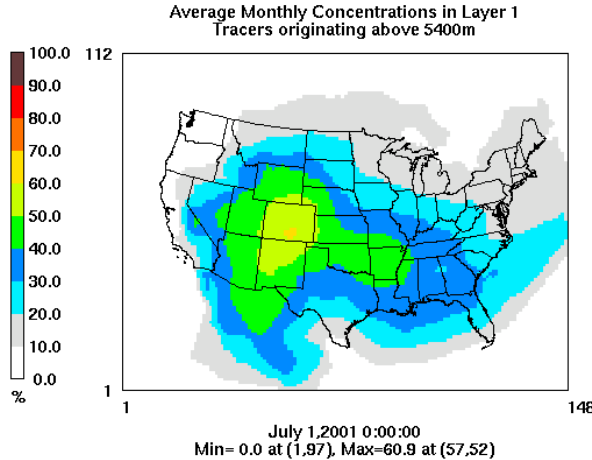
Fig. 12. Percent contribution of tracers originating above 5400m to surface layer air mass, using 2001 meteorological inputs with 34 vertical layers. Contributions are based on monthly averages of tracer